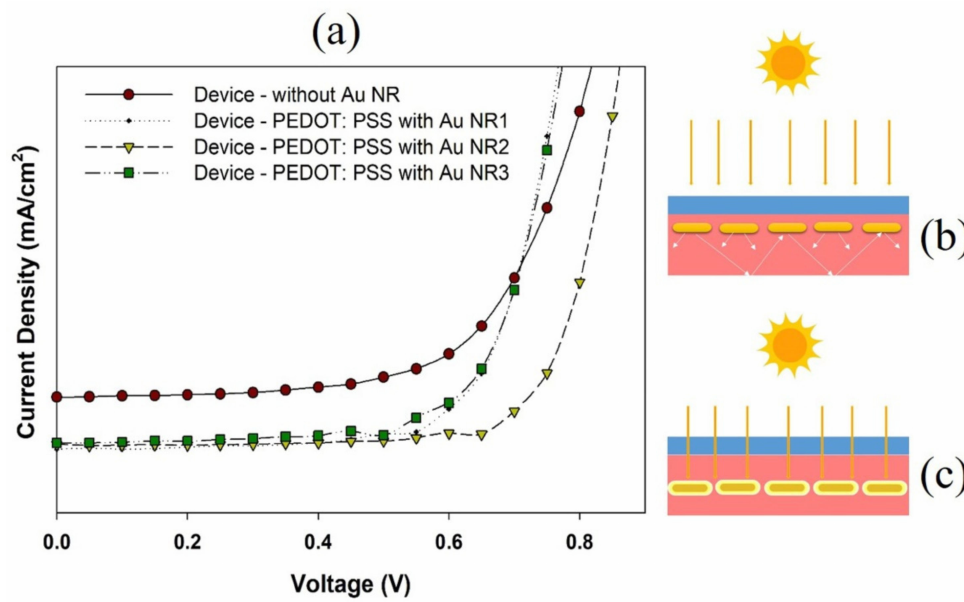
Figure 4. ( a ) The current density–voltage (J-V) curves of the device without and with Au NPs- incorporated PEDOT:PSS with different of size; ( b , c ) Schematic of the scattering when Au nanorods are incorporated in PEDOT:PSS layers. Table 1. Device parameters of cells as open circuit voltage (Voc), short circuit current density (Isc), fill factor (FF), and power conversion efficiency (PCE) without and with Au NRs incorporated in the PEDOT:PSS layers under A.M 1.5G illumination at 100 mW/cm 2 . V oc